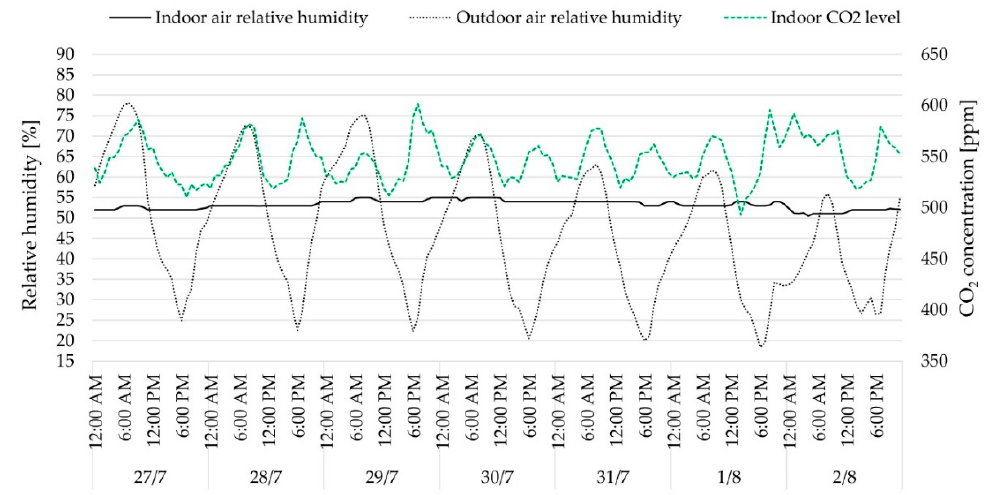
Figure 13. Monitored indoor air relative humidity and CO 2 concentration level vs. outdoor air relative humidity for the hottest week in summer.